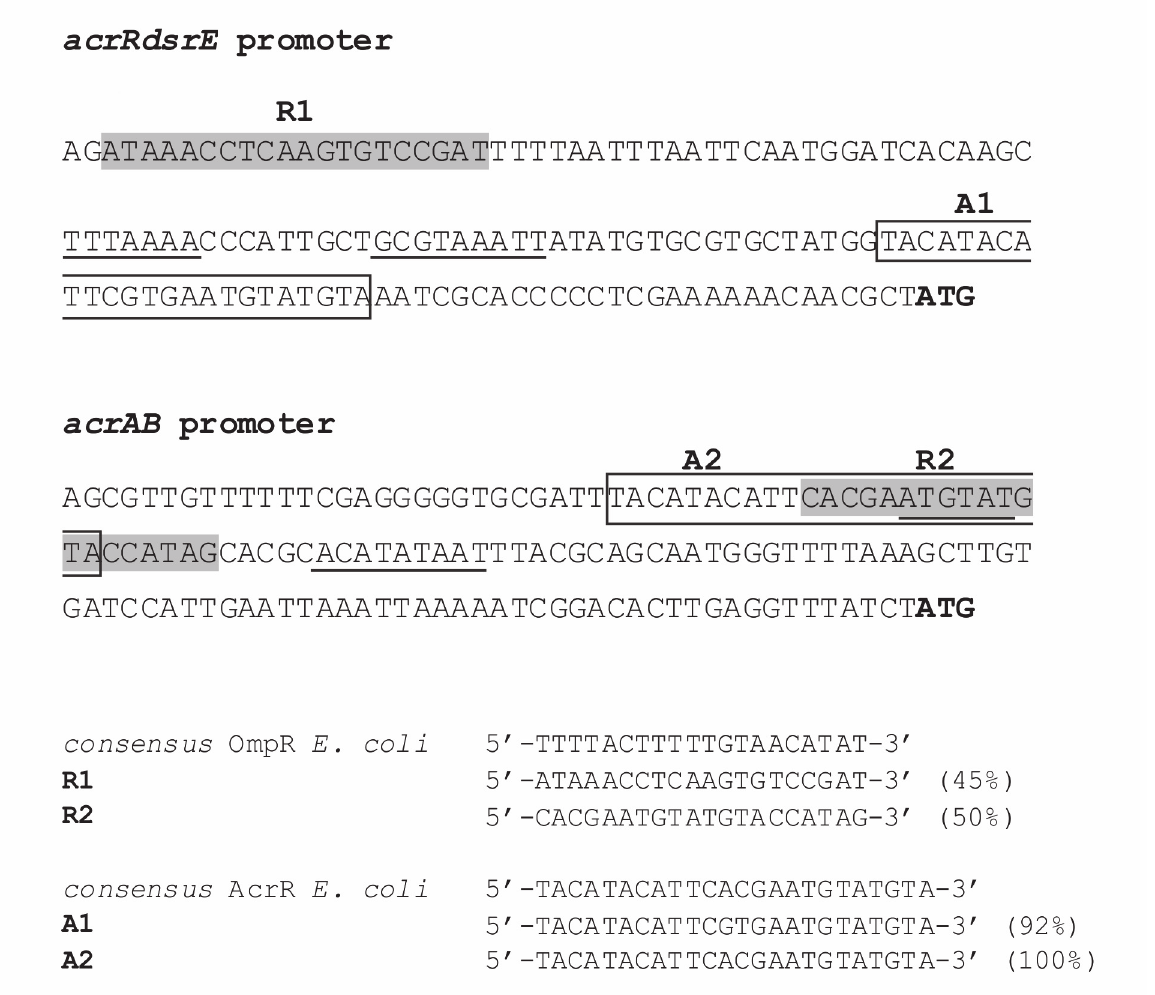
Fig 4. Intergenic sequences upstream of the Y . enterocolitica acrR and acrAB operons. The initiation codons (ATG) are in bold, and putative -35 and -10 promoter elements are underlined. The putative OmpR binding sites identified by in silico analysis (R1, R2) are shaded gray. Potential binding sites for AcrR (A1, A2) are boxed. Potential binding site elements aligned with the E . coli consensus sequences, with the percentage identities presented in